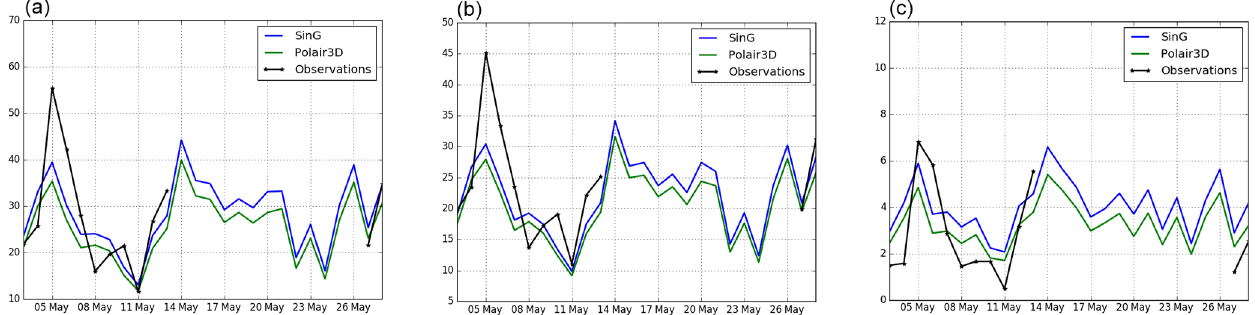
Figure 13. Daily average concentrations of NO x (c) , NO 2 (b) and NO (c) (µgm − 3 ) observed and simulated at PA13 station with SinG and